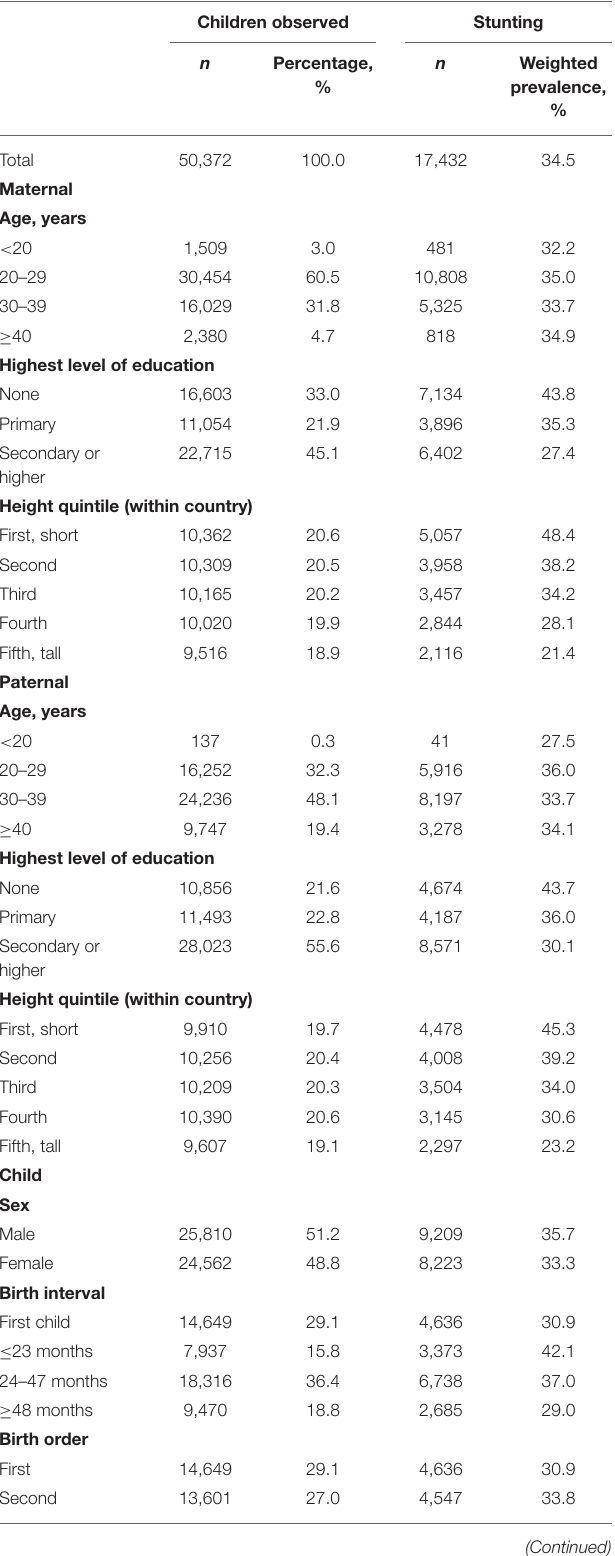
TABLE 1 | Percentage of children and weighted prevalence of stunting according to sociodemographic characteristics. Children